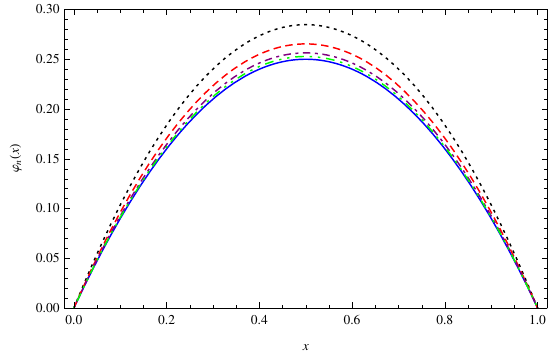
Figure 1: The exact solution u * ( x ) (solid line) and the matched n th- stage approximations φ n ( x ) for n = 4 (dot line), n = 5 (dashed line), n = 6 (dot-side line), n = 7 (dot-dot-side line).